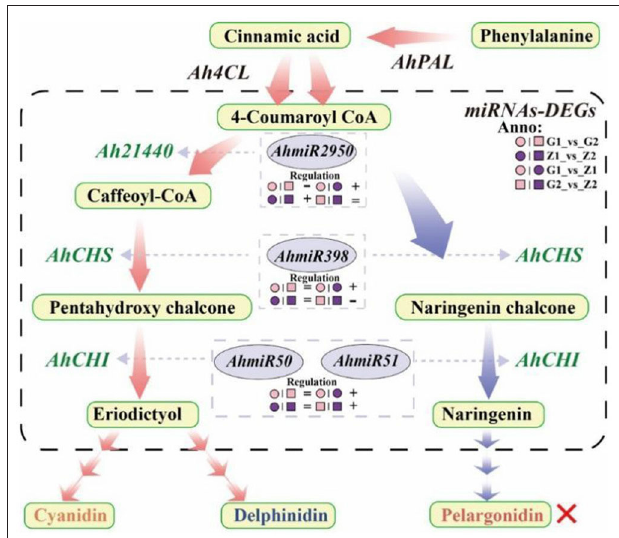
FIGURE 7 | Flow-process diagram of anthocyanin biosynthesis and miRNA interaction with target genes. The picture shows that rectangles with light yellow shading mean metabolites, light red arrows between metabolites mean preferred pathways, and light blue arrows indicate non-preferred pathways yet. The dashed rectangle indicates miRNAs-DEGs interaction. The green labels beside the arrows mean DEGs, the miRNAs corresponding to DEGs are marked in a gray ellipse, and both of them are connected by light gray arrows, and the regulation is indicated below the miRNAs. “ ◦ ” with pink and purple means 30DAF of G110 and Z18-40, respectively. “ 2 ” with pink and purple means 45DAF of G110 and Z18-40, respectively. “ + ,” “-,” and “ = ” indicate that there is a positive, negative and none regulatory relationship between DEGs and miRNAs in the comparison on the left. The red cross indicates that there are no regulation expression in the metabolites or